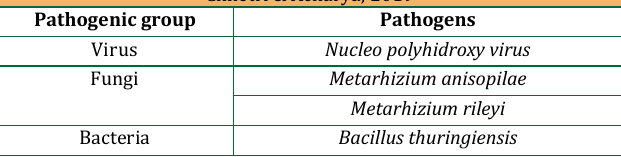
Table 3: Different groups of entomopathogens against FAW by Chhetri & Acharya,